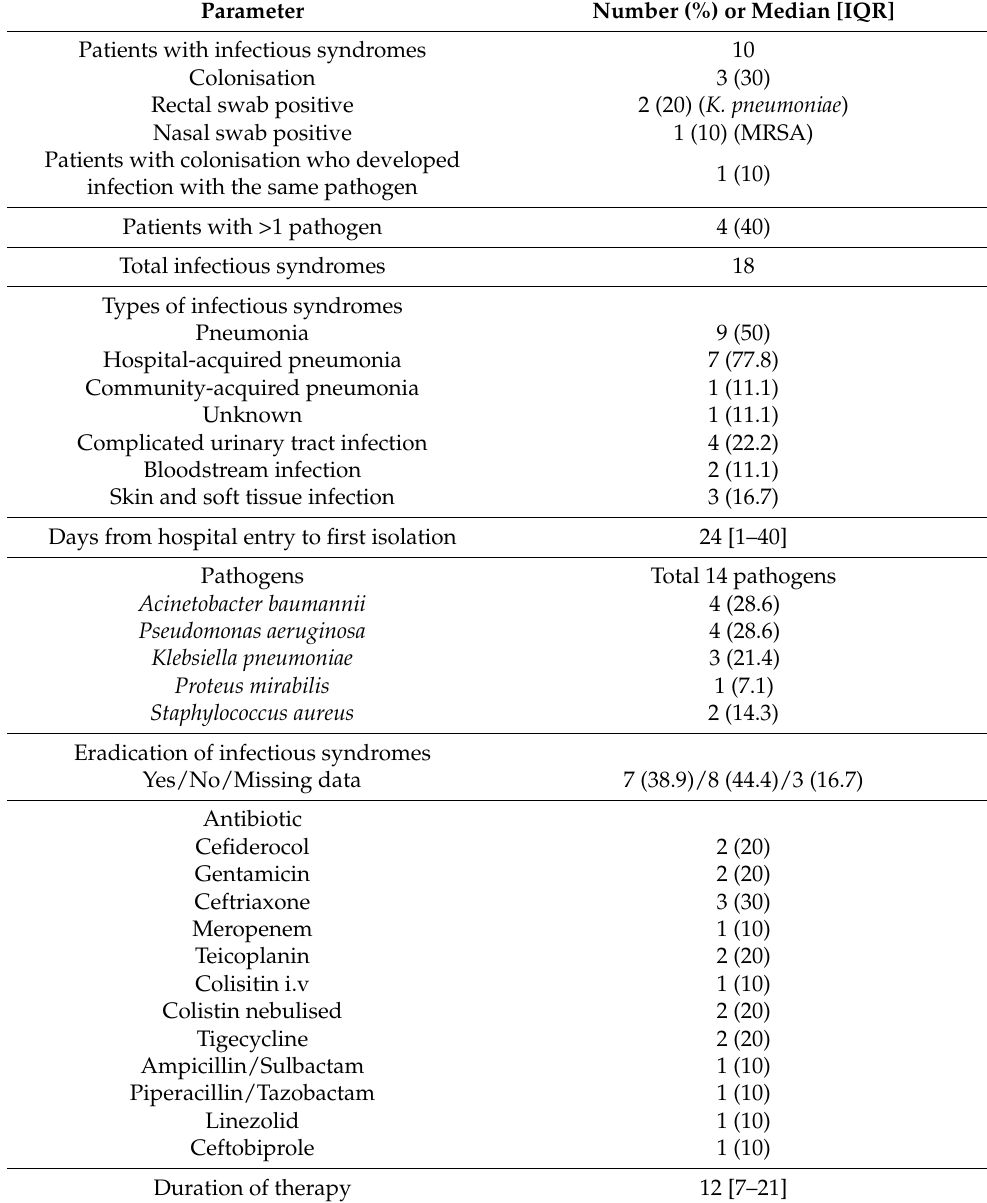
Table 2. Characteristics of MDRO/XDRO-infected